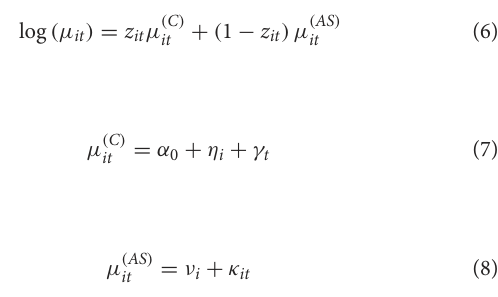
optimizing those models and improving the outputs. In this article,